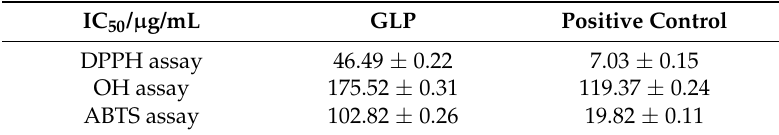
Table 1. The antioxidant activities of GLP.